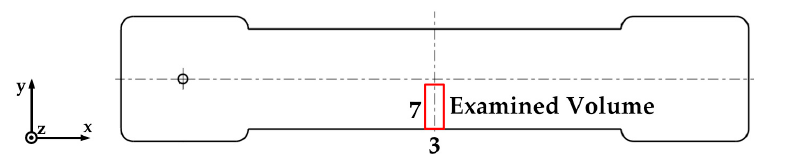
Figure 3. Position and size (in mm) of the examined sample volume by means of X-ray-micro- tomography (red).